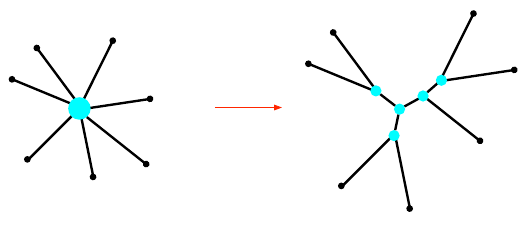
Figure 18 . A generic mass deformation of an n